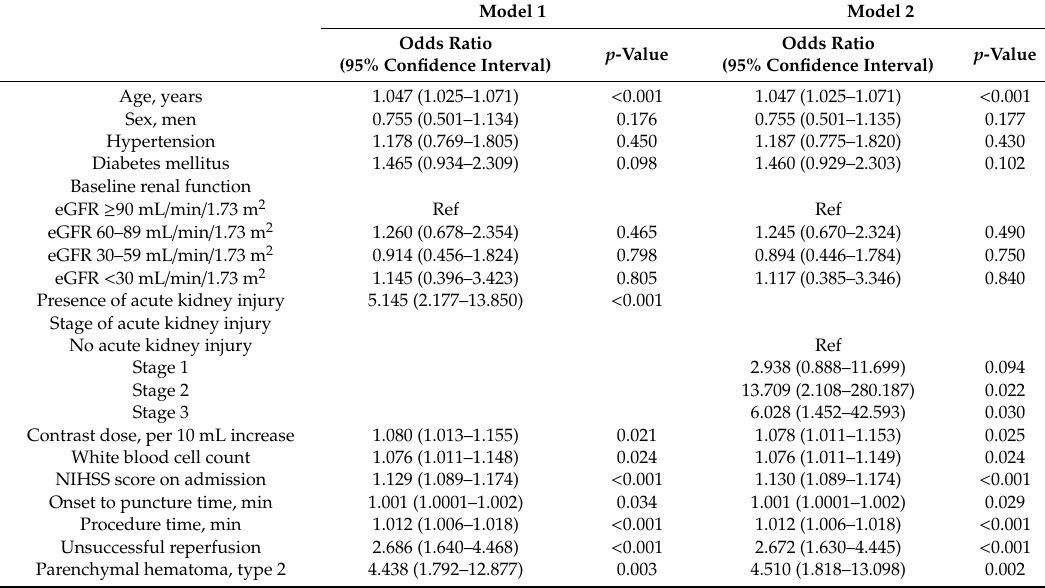
Table 3. Multivariate analysis of factors associated with a poor functional outcome at 3 months.